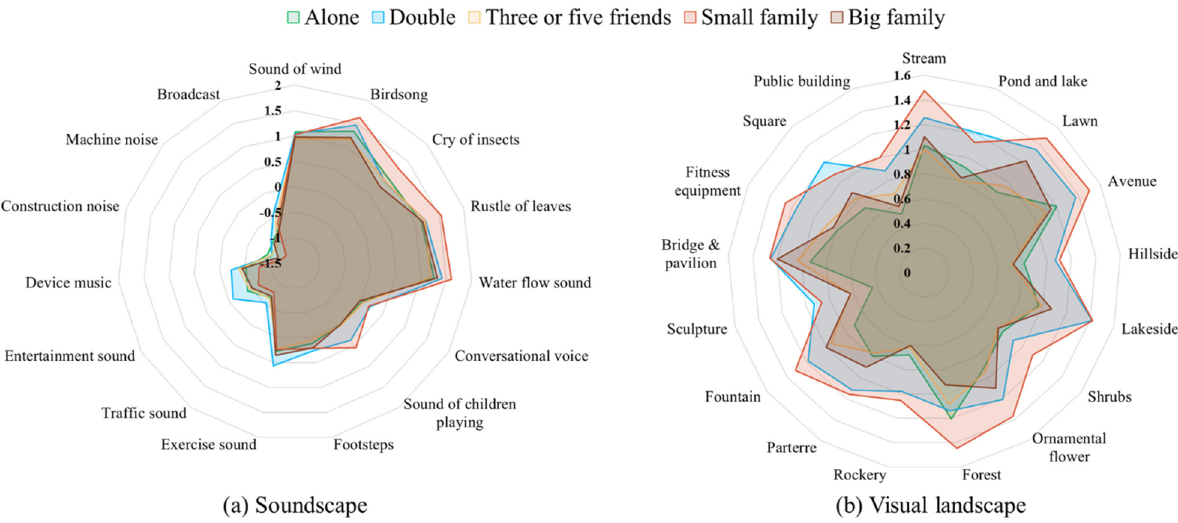
Figure 9. Radar map of soundscape ( a ) and visual landscape ( b ) preferences distribution of exercisers at different companions.